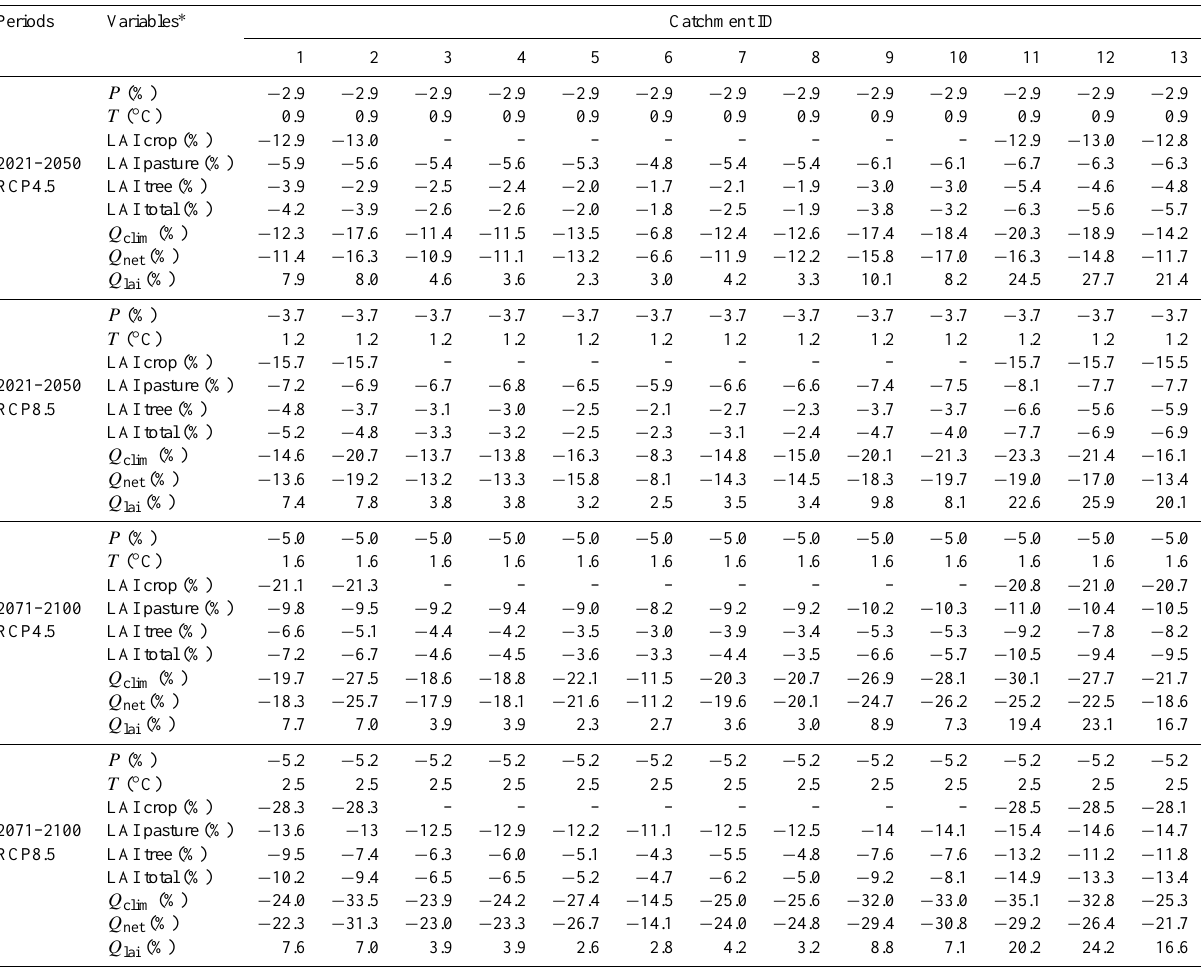
Table 3. Impacts on mean annual precipitation, temperature, LAI and streamflow of projected climate change averaged over 38 CMIP5 runs relative to